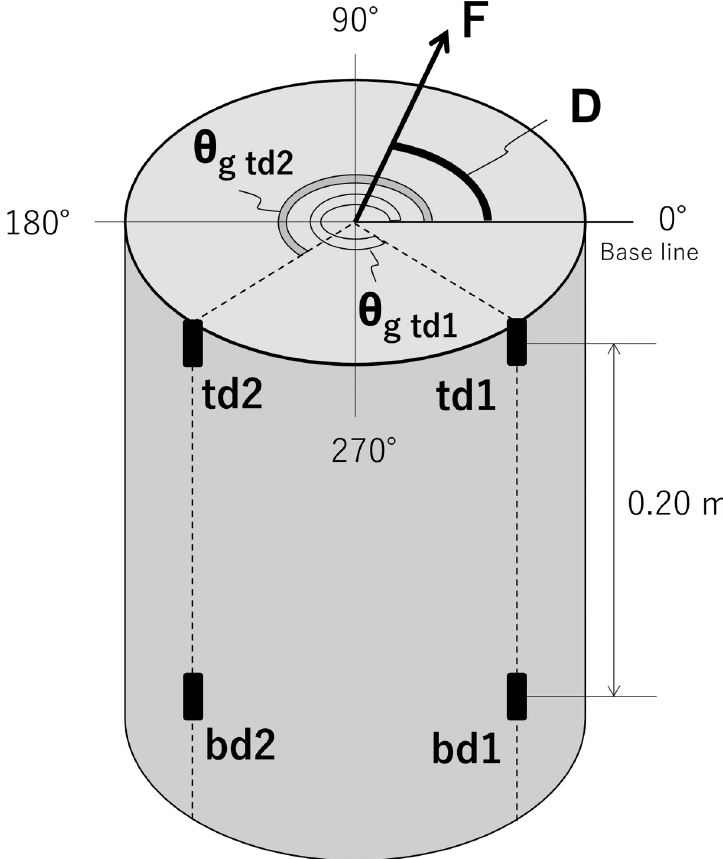
Fig 2. Schema of the arrangement of the strain gauges. A cross-section of a specimen at height h t is shown. In the panel, D gives the radial direction of the force, F, from baseline. θ g td1 and θ g td2 are the radial positions of strain gauges td1 and td2, respectively. bd1 and bd2 are the strain gauges at height h b